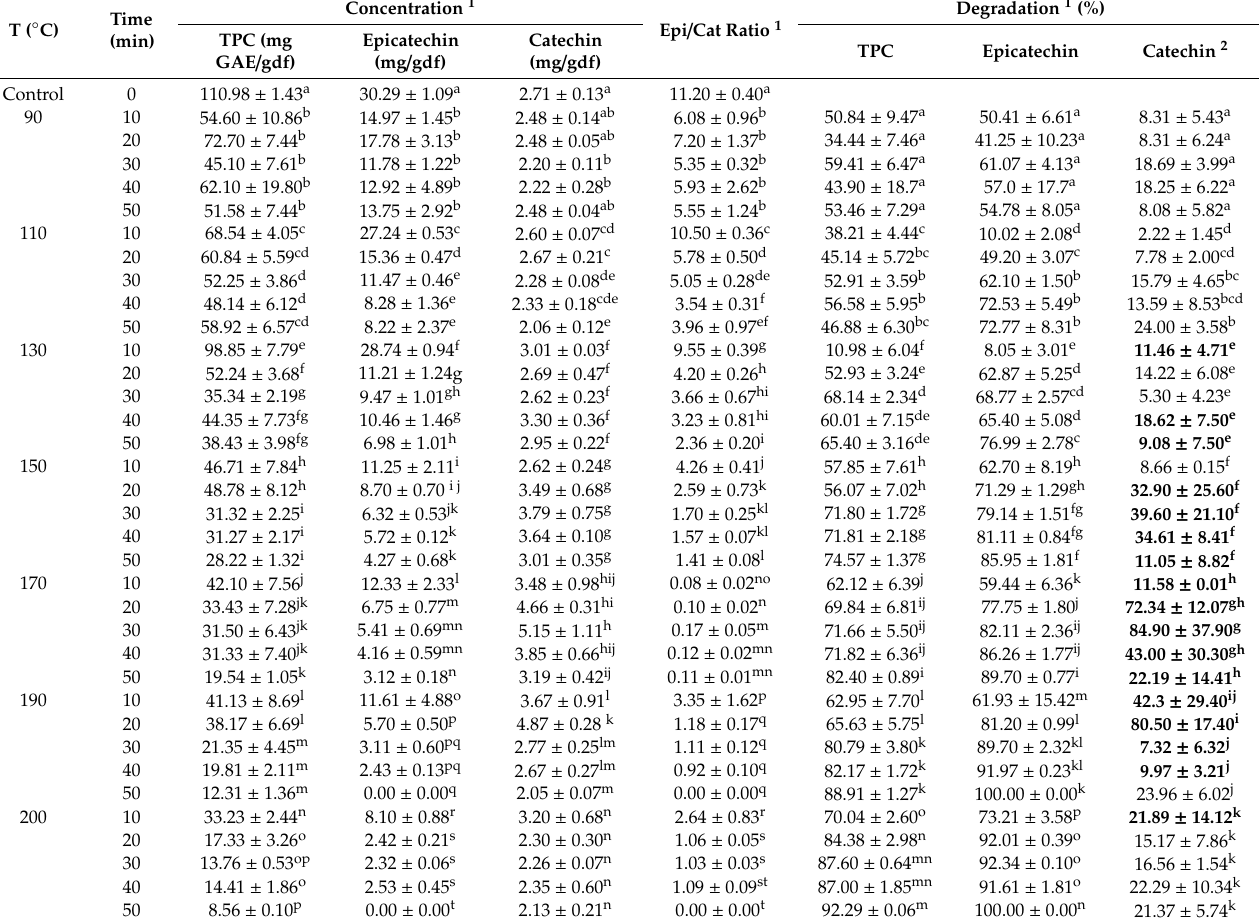
Table 1. Concentration and degradation of TPC and monomeric flavan-3-ols, epi / cat ratios, and the formation of